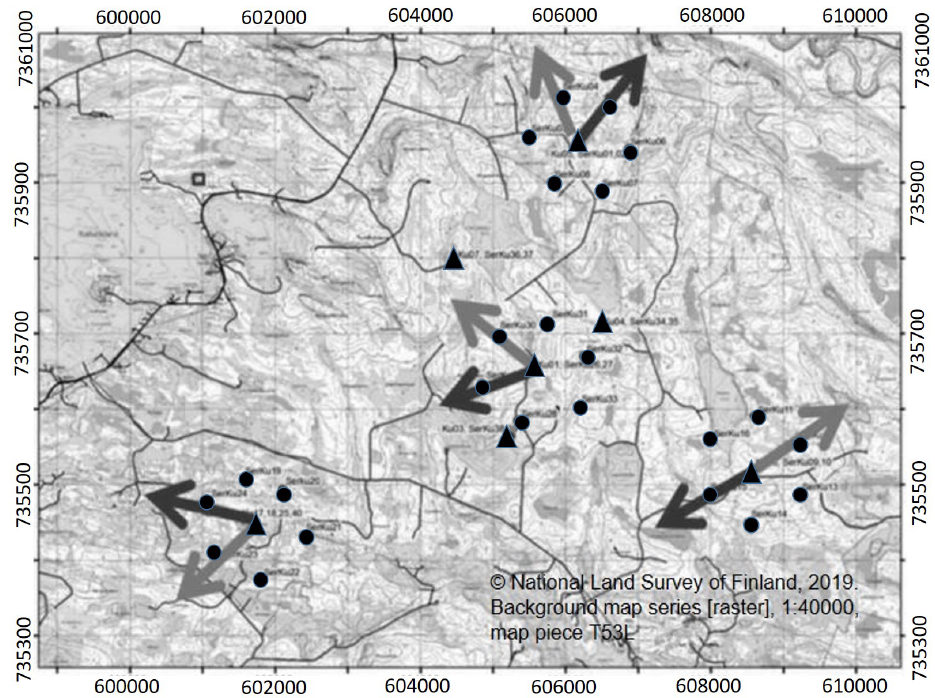
Figure 5. Azimuths to main noise sources: dots – stations of the temporary seismic array; black arrows show azimuths to noise sources in the frequency band 10–50Hz; grey arrows show azimuths to noise sources in the frequency band 5–10Hz.